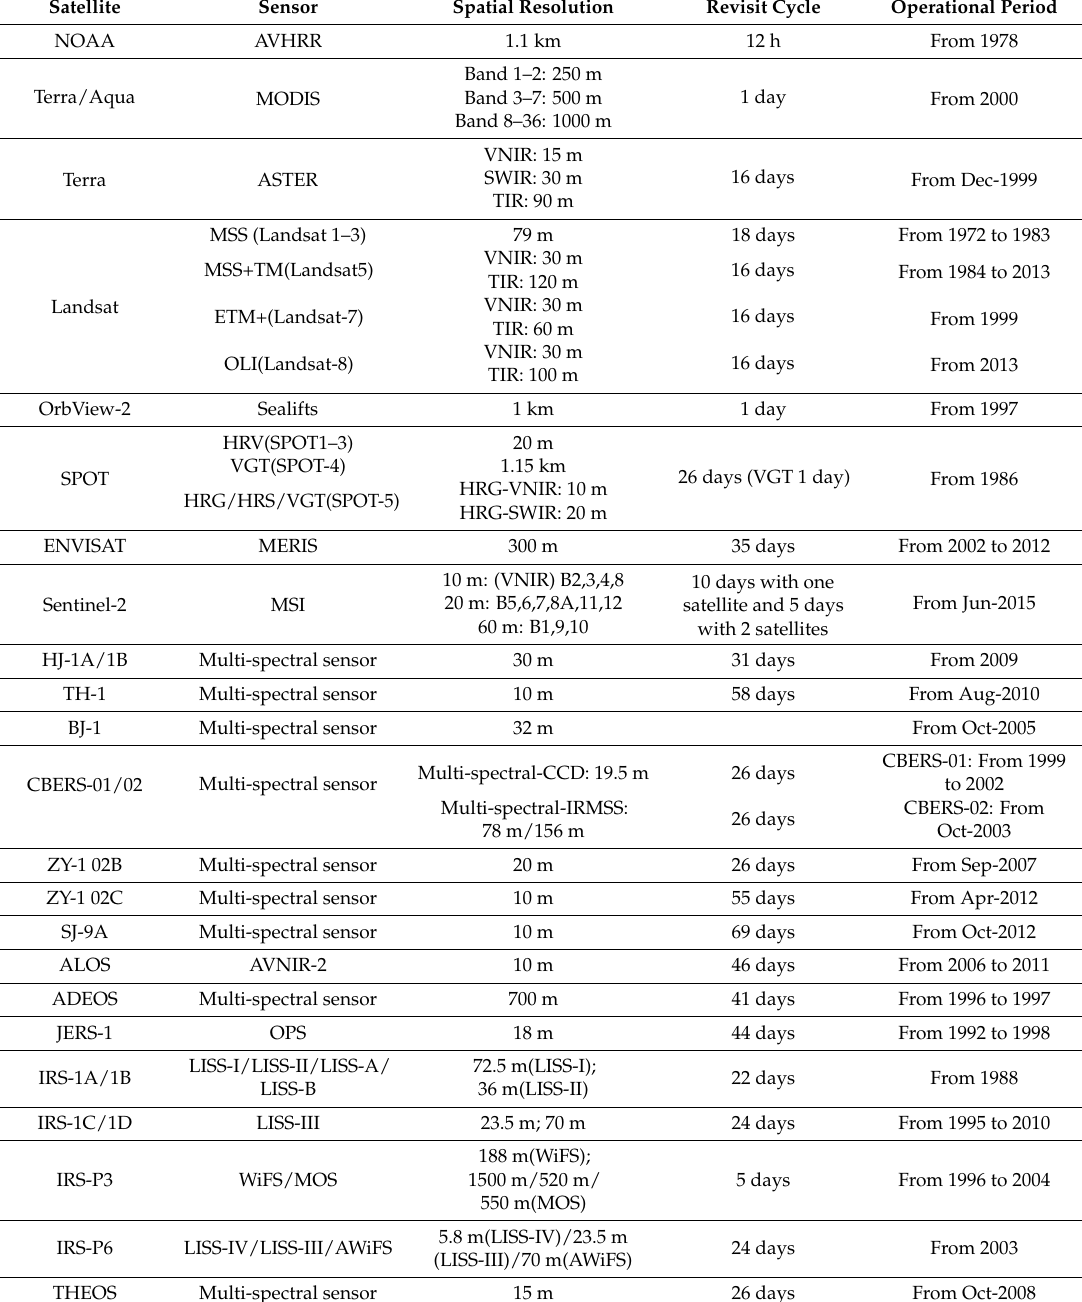
Table 1. Existing satellite sensors collecting multispectral images with spatial resolution larger than 10